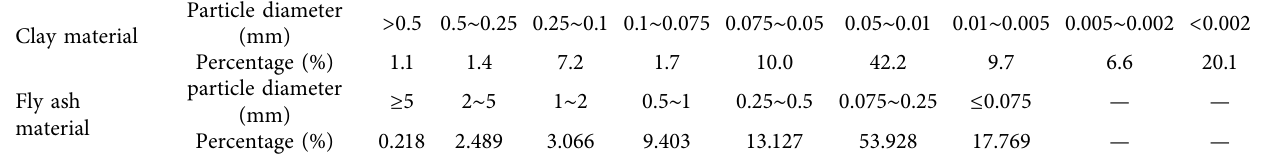
Table 3: Physical parameters of grouting